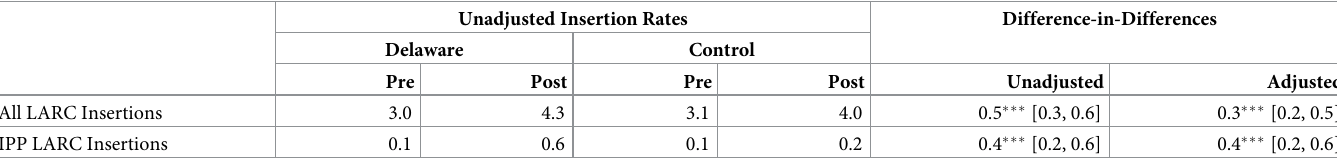
Table 2. Difference-in-differences estimates (percentage points) of the Effect of DelCAN on LARC insertion among 15–44 year olds enrolled in employer sponsored